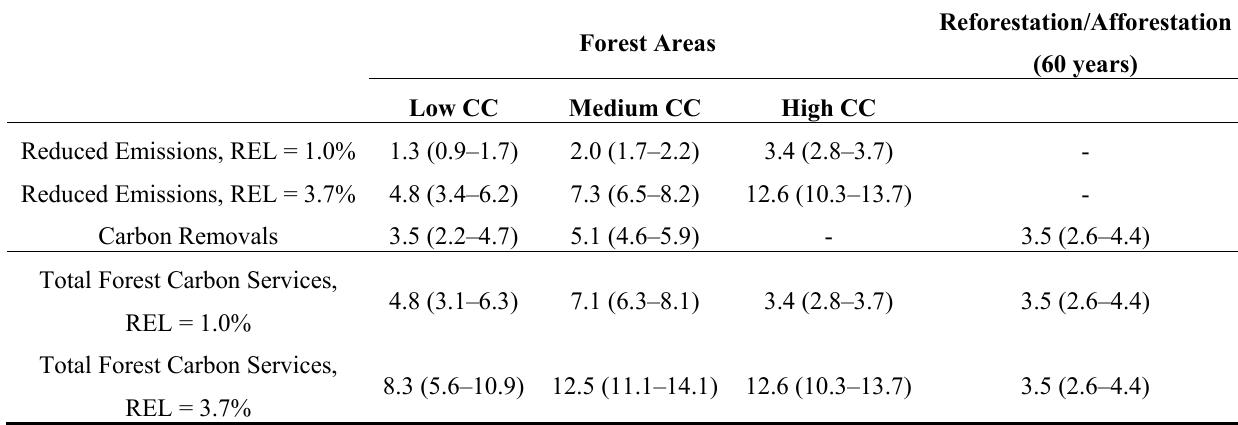
Table 7. Potential forest carbon services from reduced emissions and removals in La Primavera. All values in tCO eq/ha/year and correspond to the mean, minimum and 2 maximum values (95% CI; REL, reference emissions level).